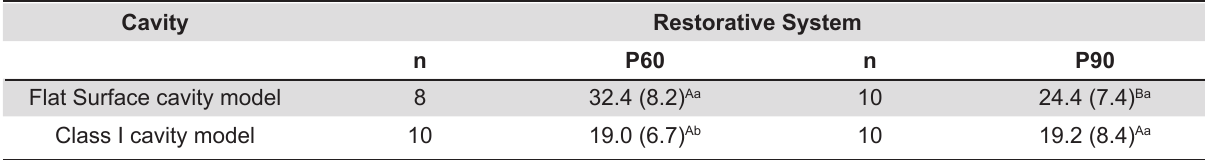
Table 1- Mean bond strength in MPa (standard deviation) considering resin and cavity model